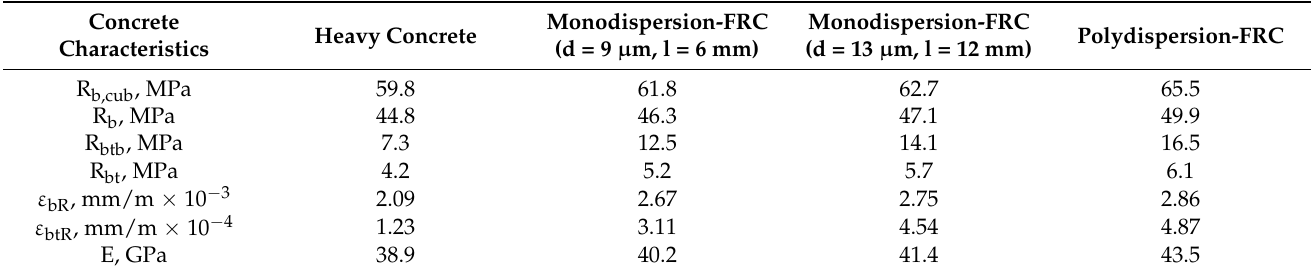
Table 8. Test results of concrete and fiber-reinforced concrete samples for strength and deformation characteristics.